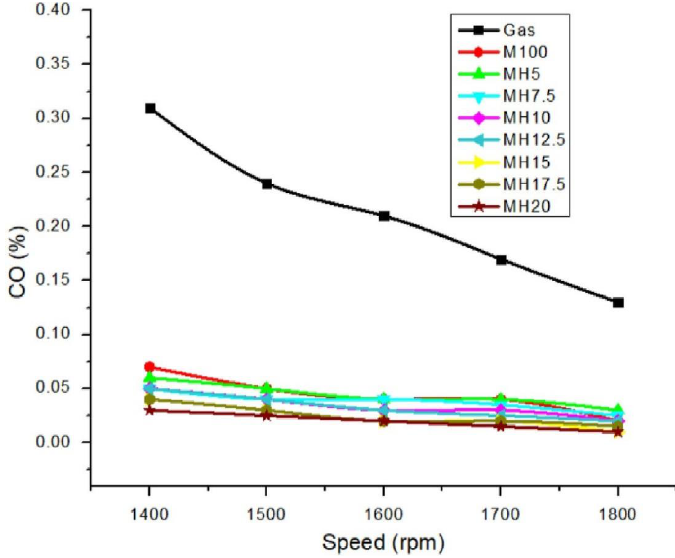
Figure 13. Reducing of CO emissions using hydrogen fuel in gasoline engines [79].